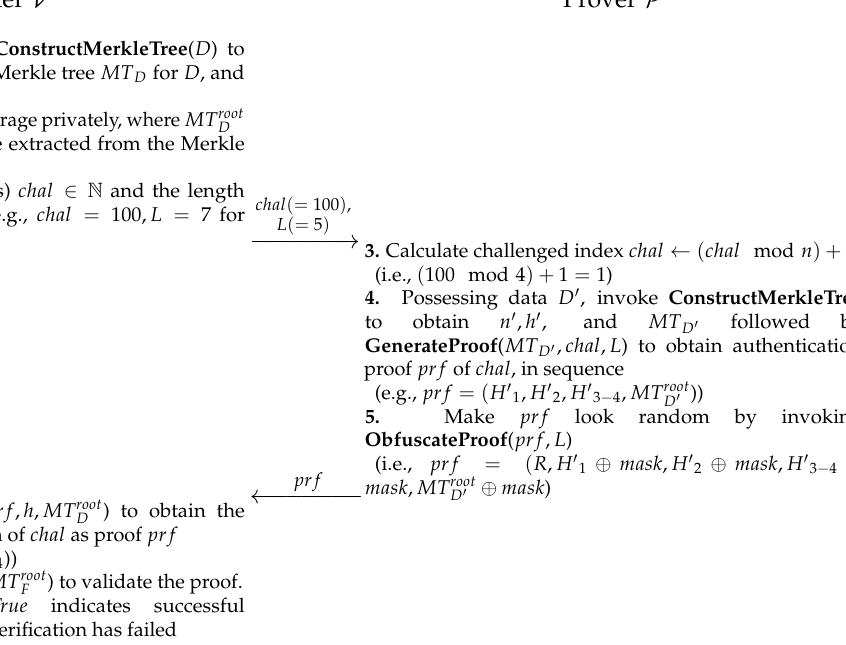
Algorithm 3 Merkle tree-based online authentication with randomized input Verifier